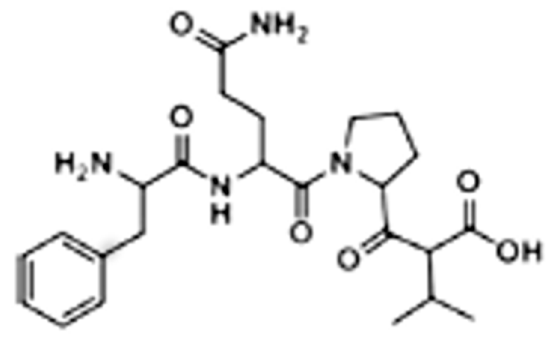
Figure 3. Primary structure of the FQPV tetrapeptide.